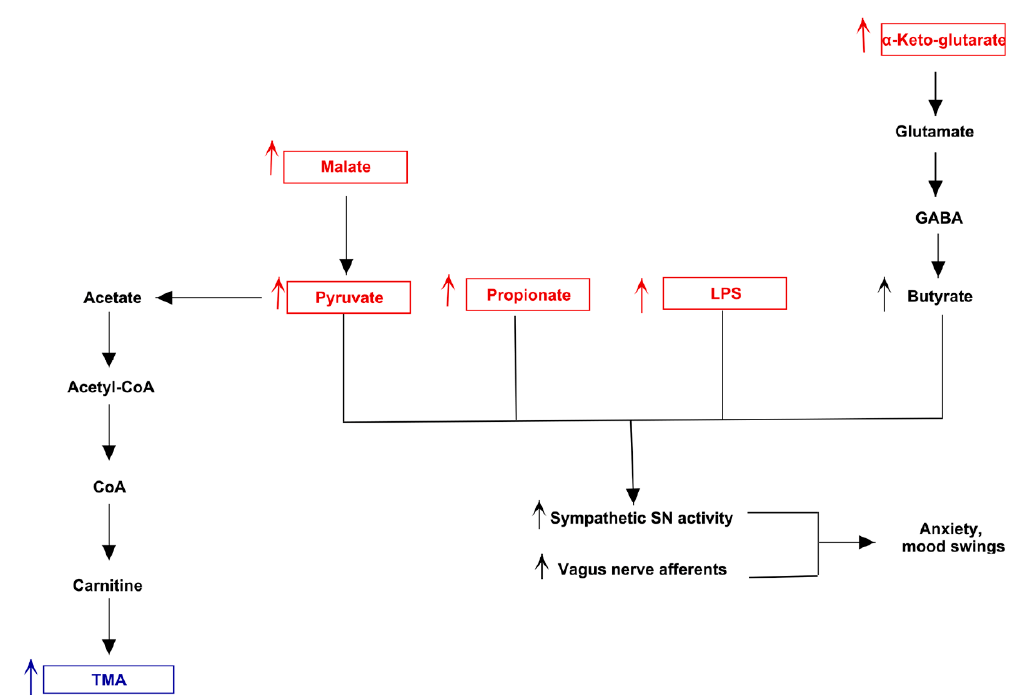
Figure 11. Biochemical pictures of TMAU patient 2. The panel represents how metabolites produced directly or indirectly by patient’s microbiota could influence the biosynthesis/release of neurotransmitters (in particular serotonin) and the production/accumulation of TMA.